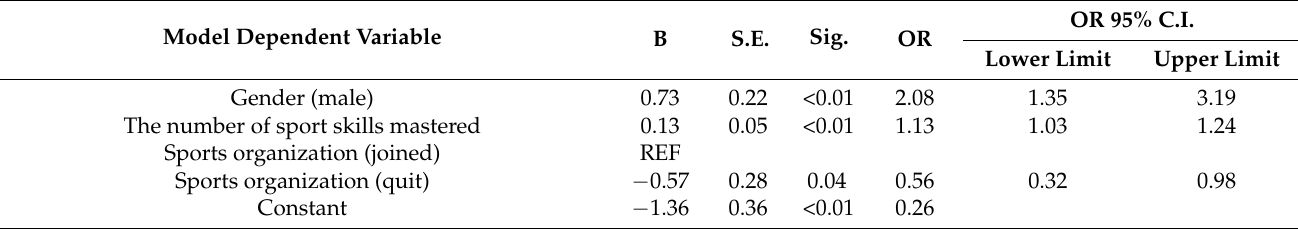
Table 7. Related factors of exercise behavior change among participants who did not achieve the PA guidelines before the